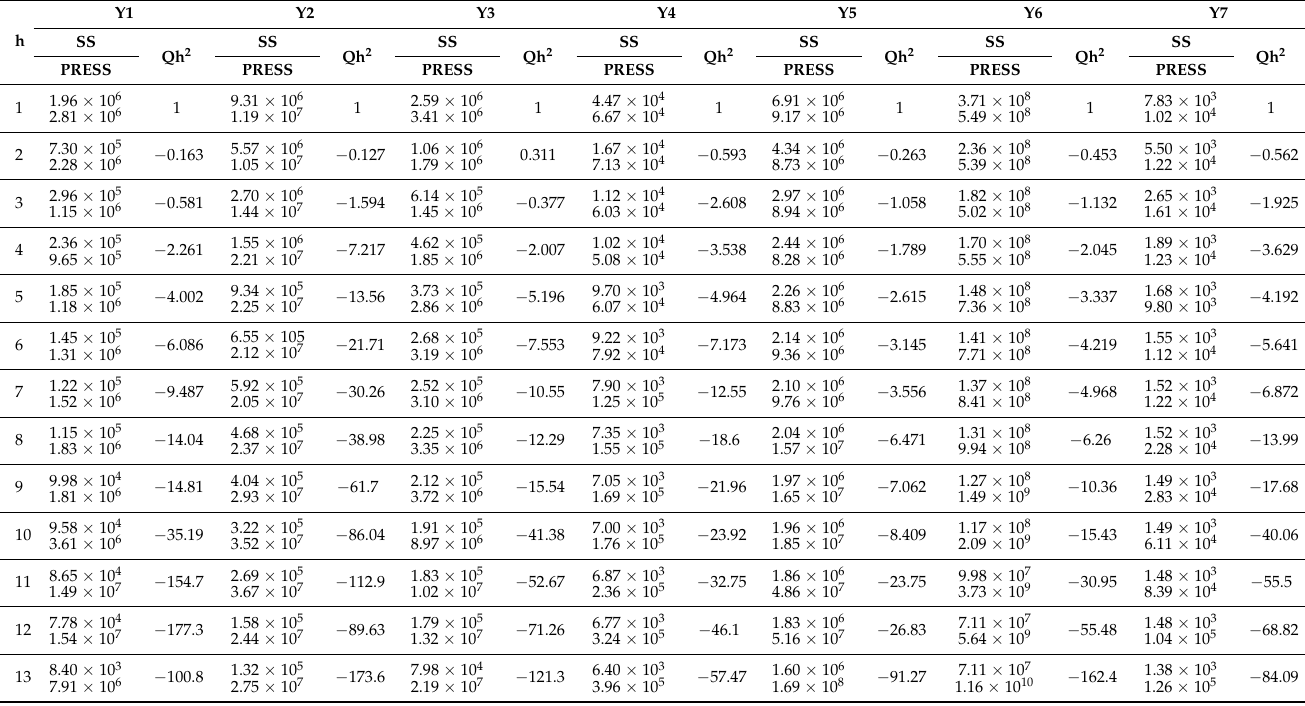
Table 6. Result of cross-validity